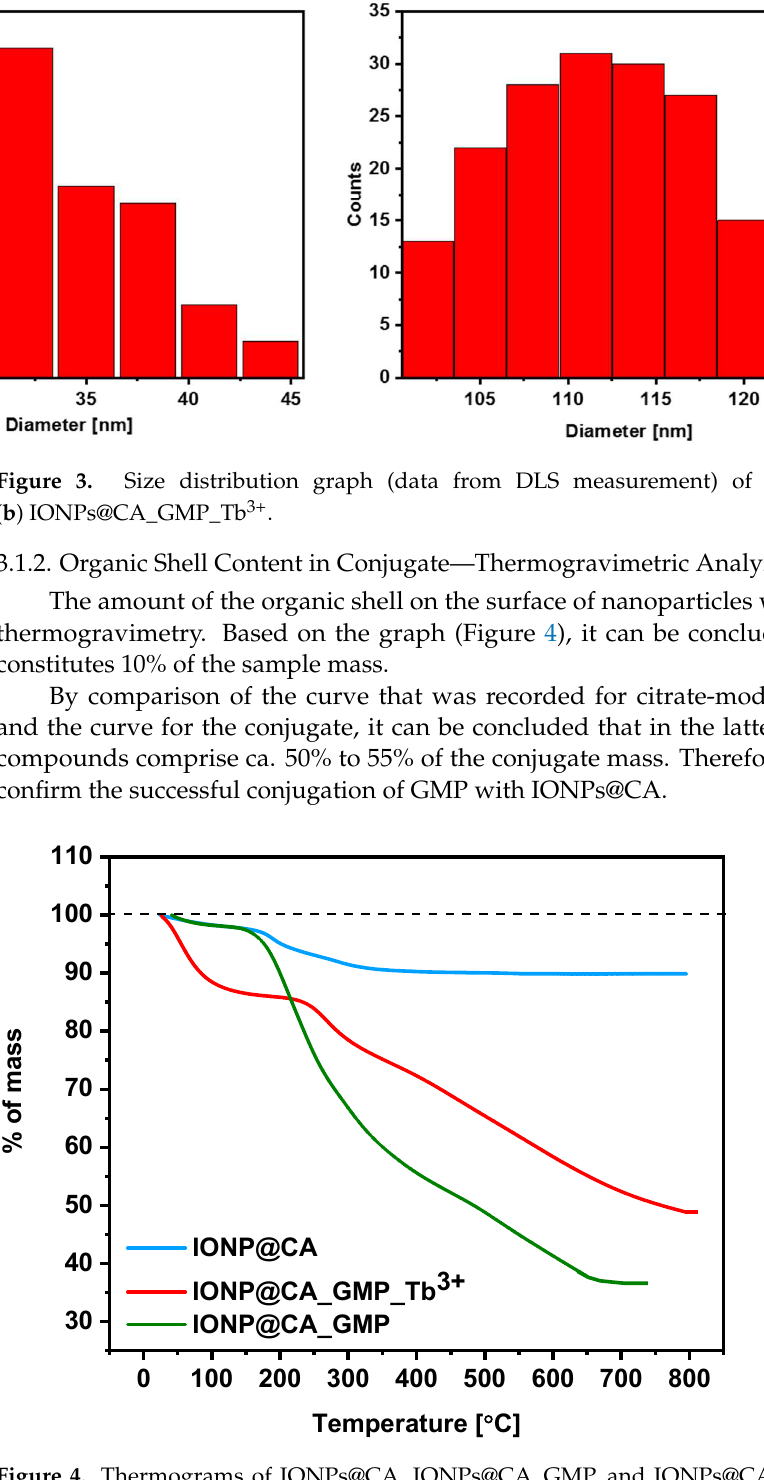
Figure 4. Thermograms of IONPs@CA, IONPs@CA_GMP, and IONPs@CA_GMP_Tb 3+ (curves marked in the graph).